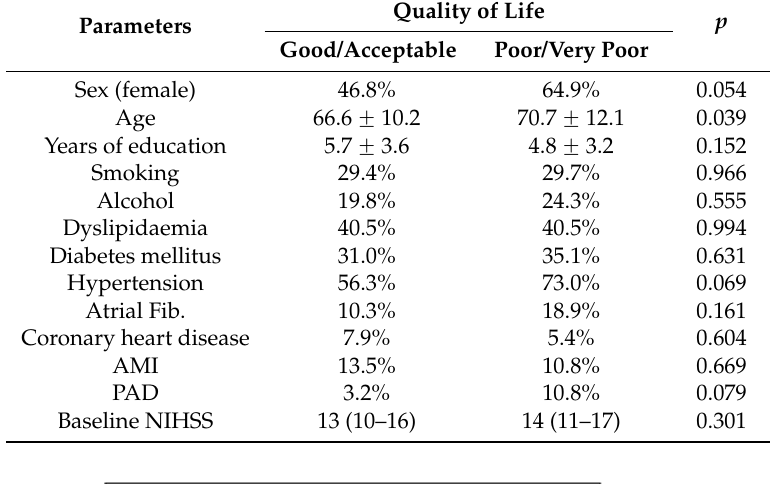
Table 3. Variables associated with poor or very poor quality of life.